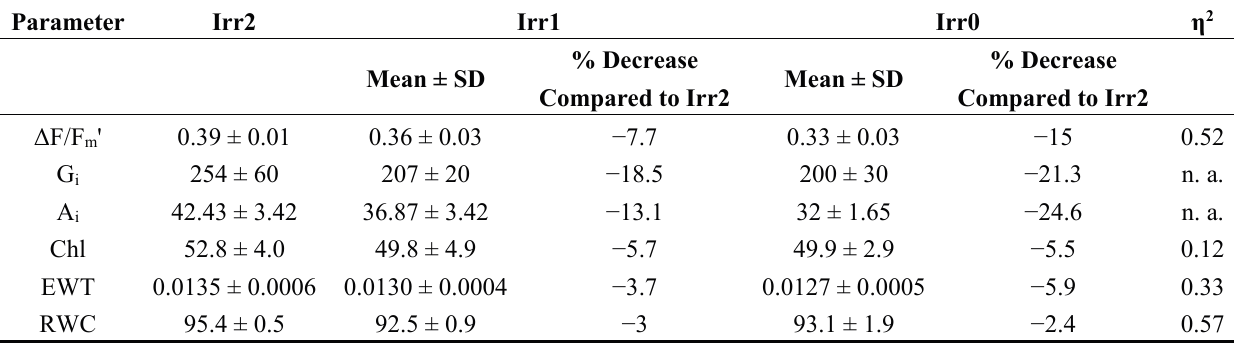
Table 4. Descriptive statistics ( i.e ., mean and standard deviation (SD)) of maize leaf parameters grouped per irrigation treatment. Photosynthetic efficiency ( Δ F/Fm'), stomatal